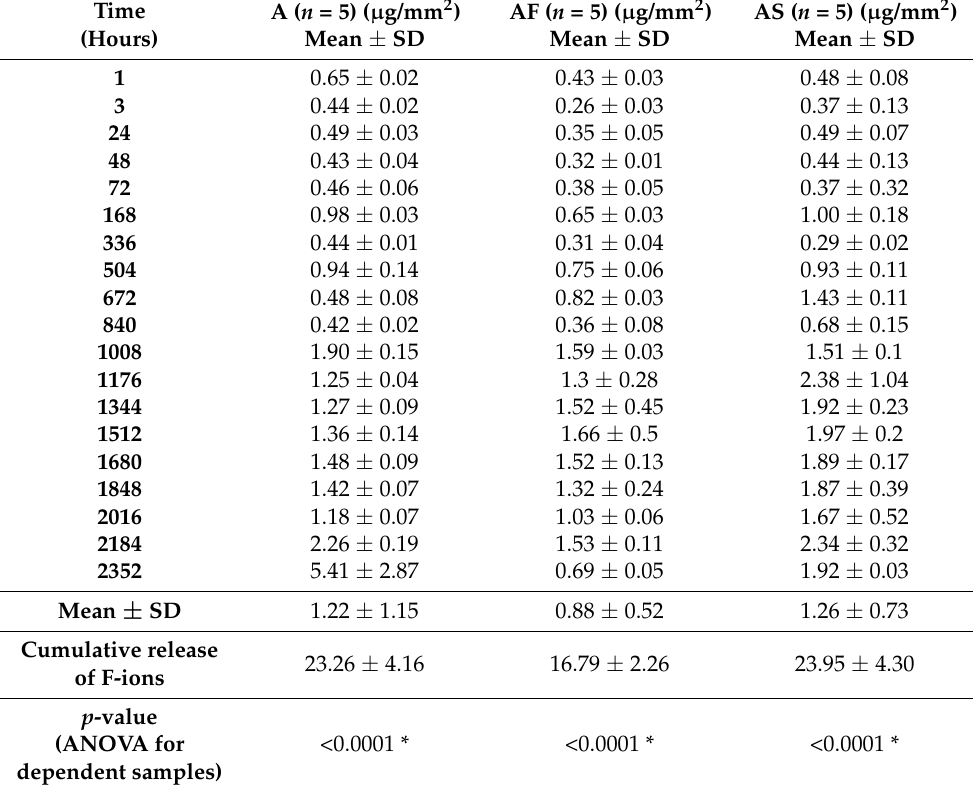
Table 3. Release of fluoride ions ( μ g/mm²) from ormocer materials (A—Admira; AF— Admira Flow; AS—Admira Seal) into deionized water in a period of 2352 h. Five sam- ples were prepared for each material.